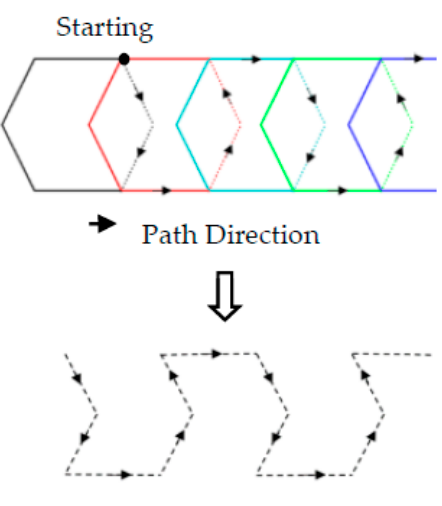
Figure 7. Nested hexagons and obtaining the NHexCurves pattern.